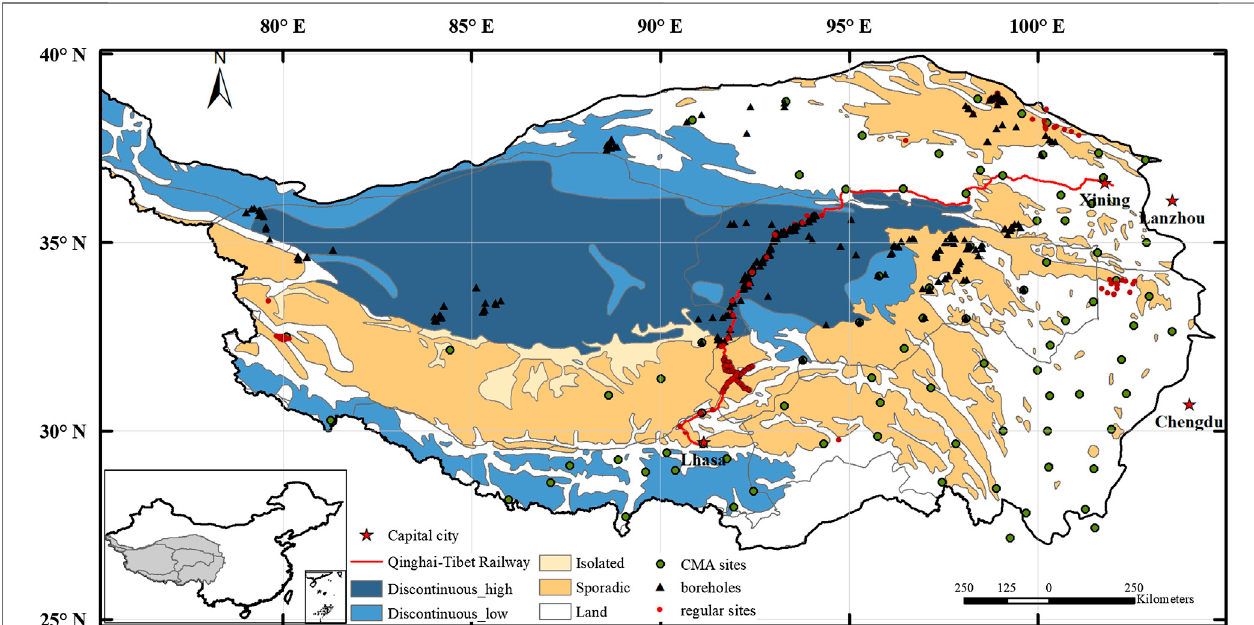
FIGURE 1 | The distribution of permafrost and in-situ observations over the Tibetan Plateau region. The permafrost classi fi cation is based on the international permafrost association permafrost map (Brown et al., 1997), and the “ high ” and “ low ” in the legend refer to the ice content of permafrost. Green dots represent meteorological stations from China Meteorological Administration, black triangles refer to the borehole sites with deeper soil temperature measurements from previous studies (Wu and Zhang, 2008; Luo et al., 2012; Cao et al., 2019), and red dots are regular observation sites with soil temperature observations within a depth of a few meters (data source including Yang et al., 2013a; Cao et al., 2019; Zheng et al., 2020).